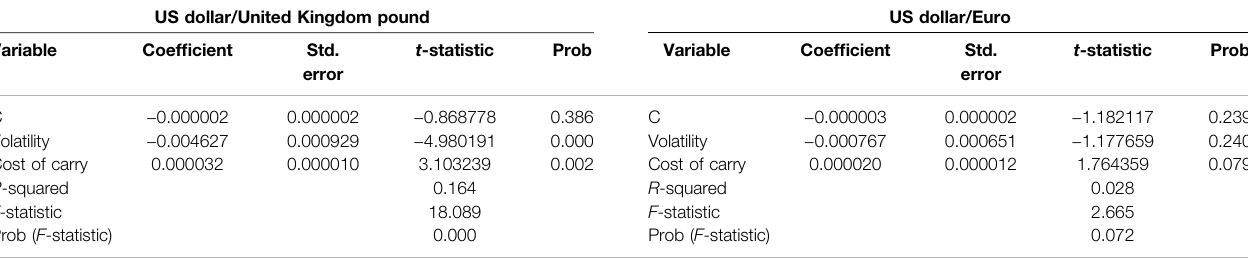
TABLE 5 | Multiple regression results.